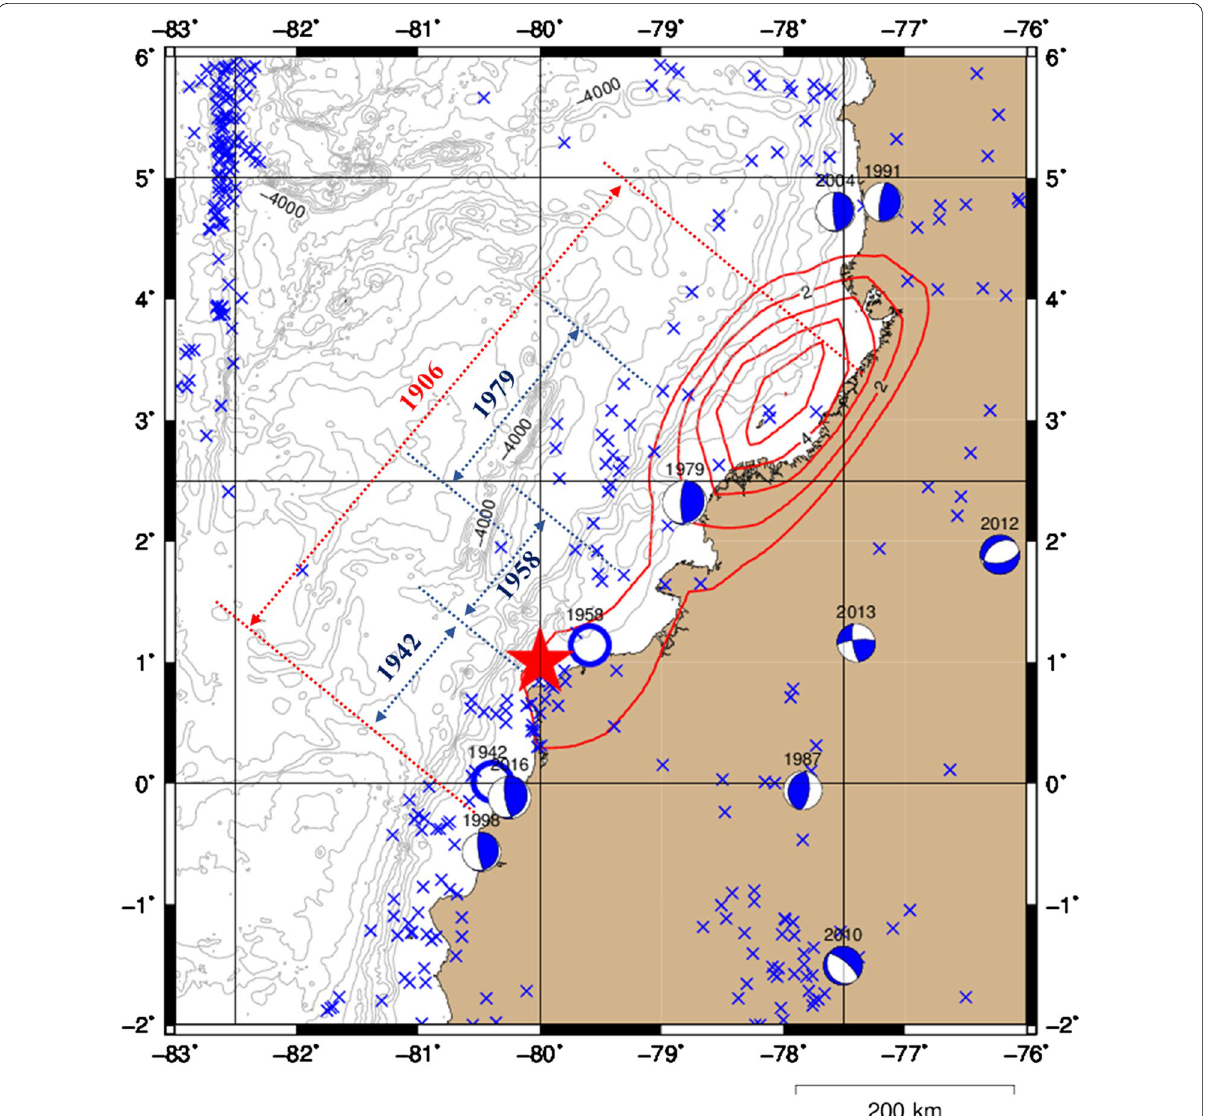
Fig. 4 Comparison of the estimated slip distribution with the seismicity around the Colombia–Ecuador subduction zone. The gray contour lines show the bathymetry at 500‑m intervals, and red contour lines show the slip distribution at 1‑m intervals based on the results of the inverse analy‑ sis. The red star indicates the epicenter of the 1906 earthquake based on Chlieh et al. (2014). The blue cross symbols indicate earthquakes of M w 4.0 or higher that occurred from January 31, 1971, to June 30, 2017, as obtained from the Global CMT Catalogue (Dziewonski et al. 1981; Ekström et al. 2012); mechanisms are shown only when M w is greater than 7.0. The blue circles indicate the epicenter locations of the 1942 and 1958 earthquakes (surface magnitudes of 7.9 and 7.8, respectively) based on Mendoza and Dewey (1984). The vectors indicate the assumed rupture length of the major historical earthquakes based on Kelleher (1972) and Kanamori and McNally